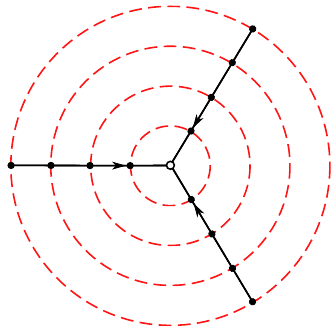
Figure 3 . The \wheel" Feynman graph corresponding to O ( (cid:24) 24 ) term in the weak coupling expan- sion (1.7) of anomalous dimension of the operator Tr( (cid:30) 3